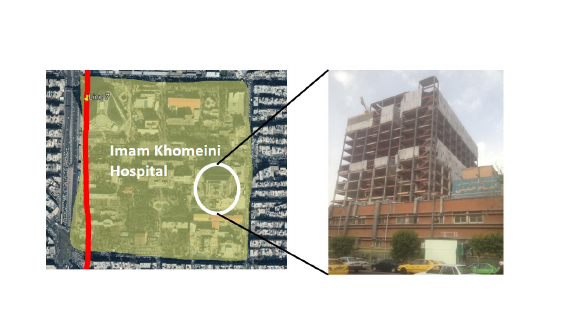
Figure 14: Location of Imam Khomeini hospital (light green hatch in the left picture) as the most famous hospital in Iran in vicinity of subway lines and its civil works for